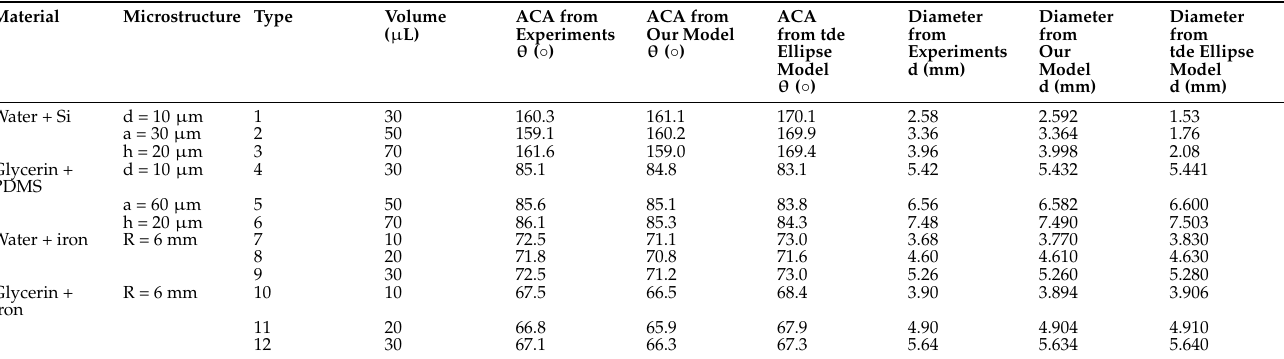
Figure 7. Picture comparations of results from our model, experiments and the ellipse model. Picture numbers 1–12 are respectively related to the 12 wettable types in Table 1. Profiles from our model are shown with red lines, those of experiments with yellow lines and those of the ellipse model with blue lines. The ellipse model is from Lubarda’s paper [11]. Table 1. 12 Wettable types and results from the experiments, our model and the ellipse model.